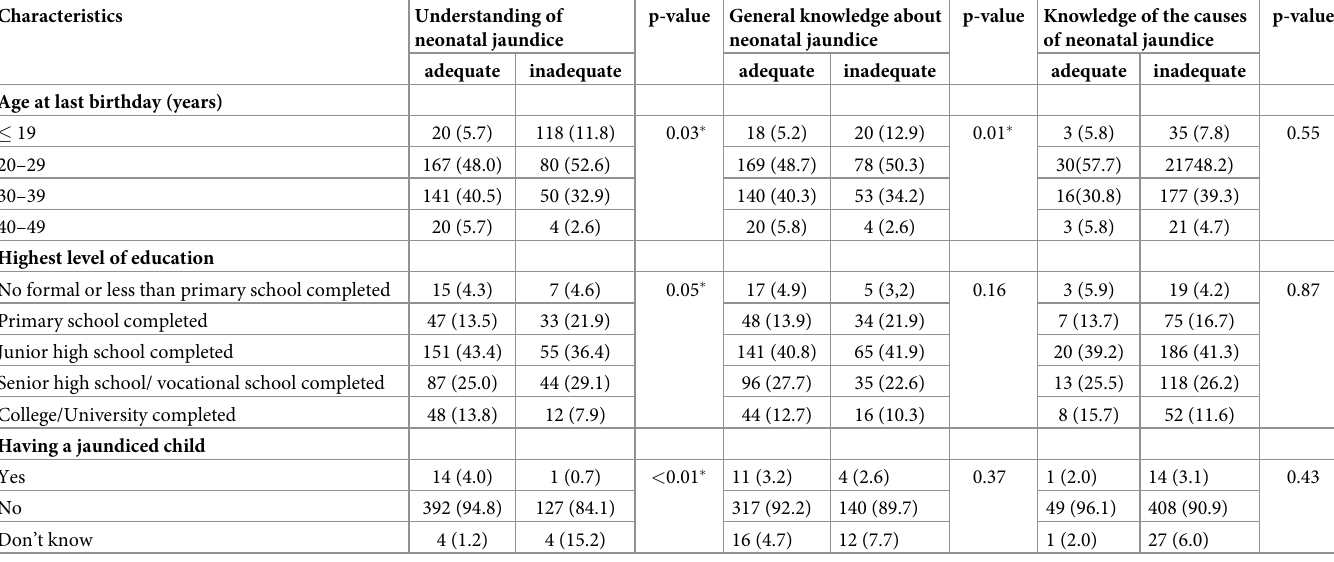
Table 4. Association between selected characteristics of mothers and knowledge of neonatal jaundice. Characteristics